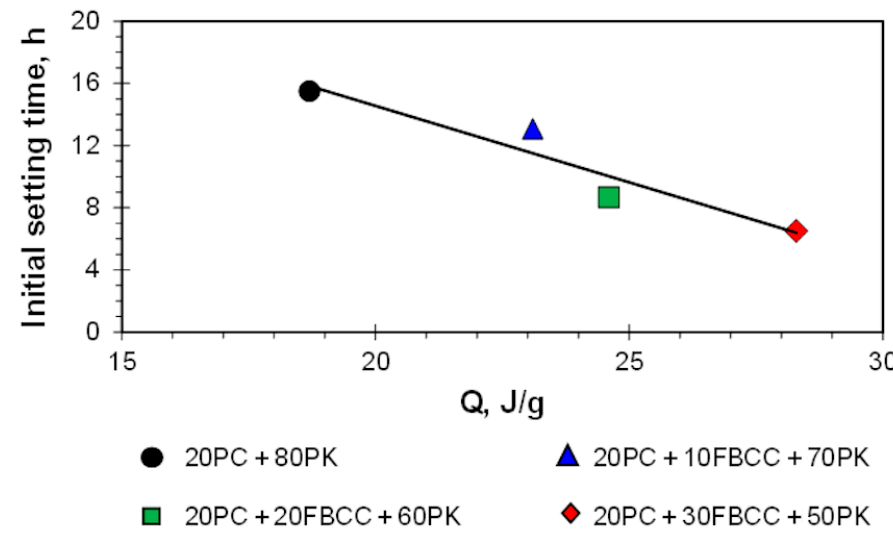
Figure 3. Dependence of initial setting time on heat released in the same period.